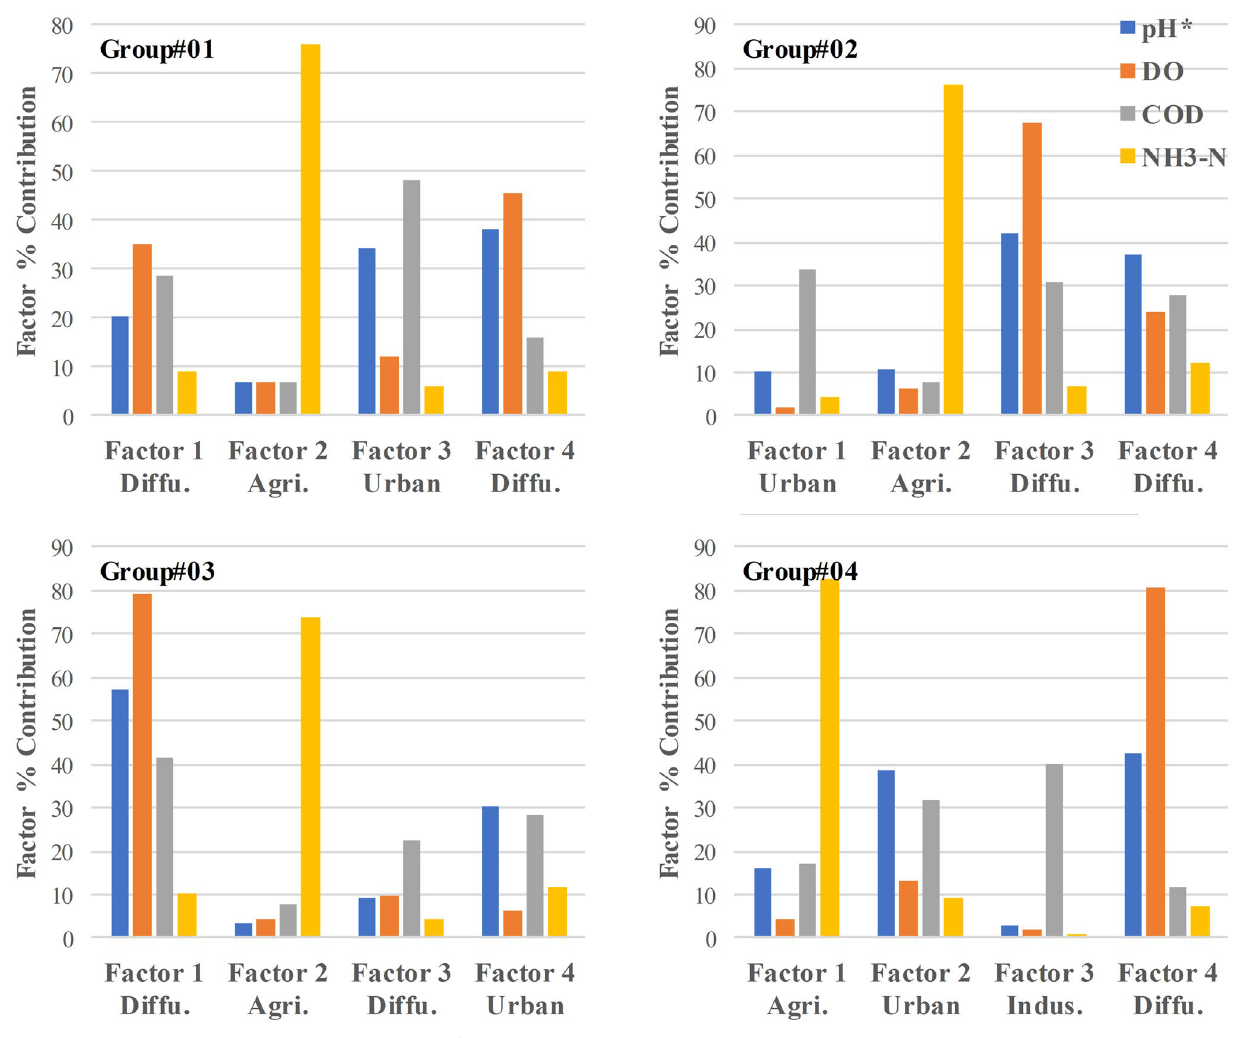
Fig. 5 Spatial factor loadings obtained from PMF analysis of water quality parameters of Huaihe River basin. (For group#01: Factor 1 and Factor 4 = diffused land use, Factor 2 = agricultural land use and Factor 3 = urban land use. For group#02: Factor 1 = urban land use, Factor 2 = agricultural land use, Factor 3 and Factor 4 = dif- for Huaihe river water quality impairment (Xiao et al.